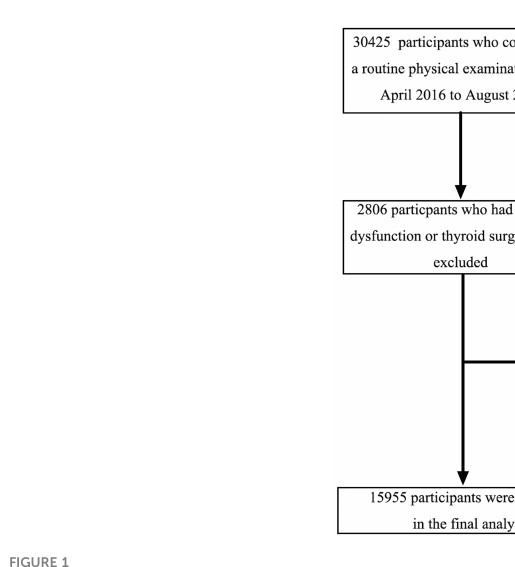
FIGURE 1 The fl owchart of the study